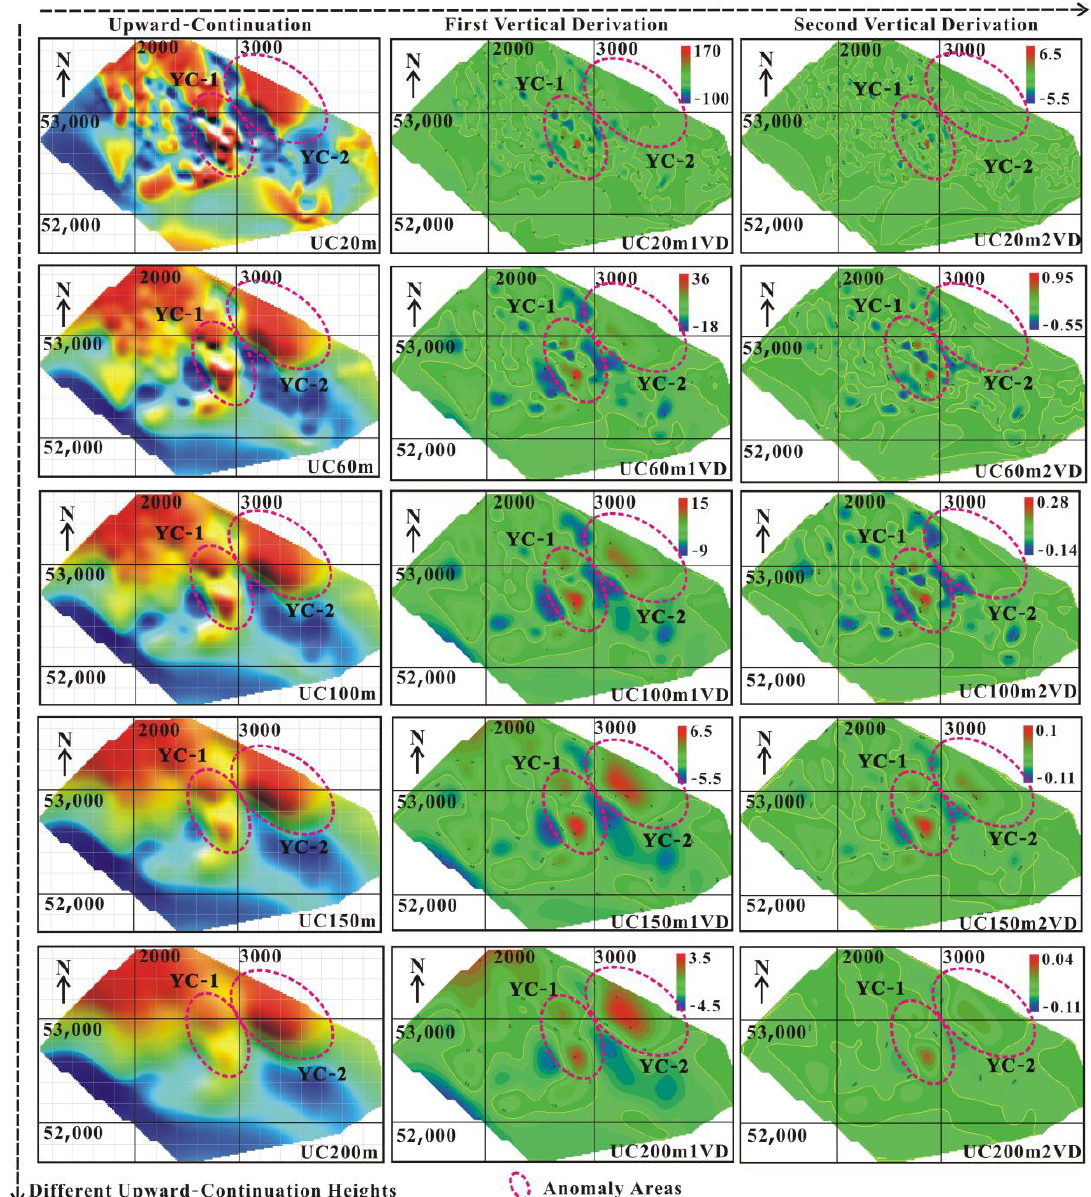
Figure 6. Diagram of the upward continuation and vertical derivation of magnetic measurement data in the Gongchangling iron ore concentration area.